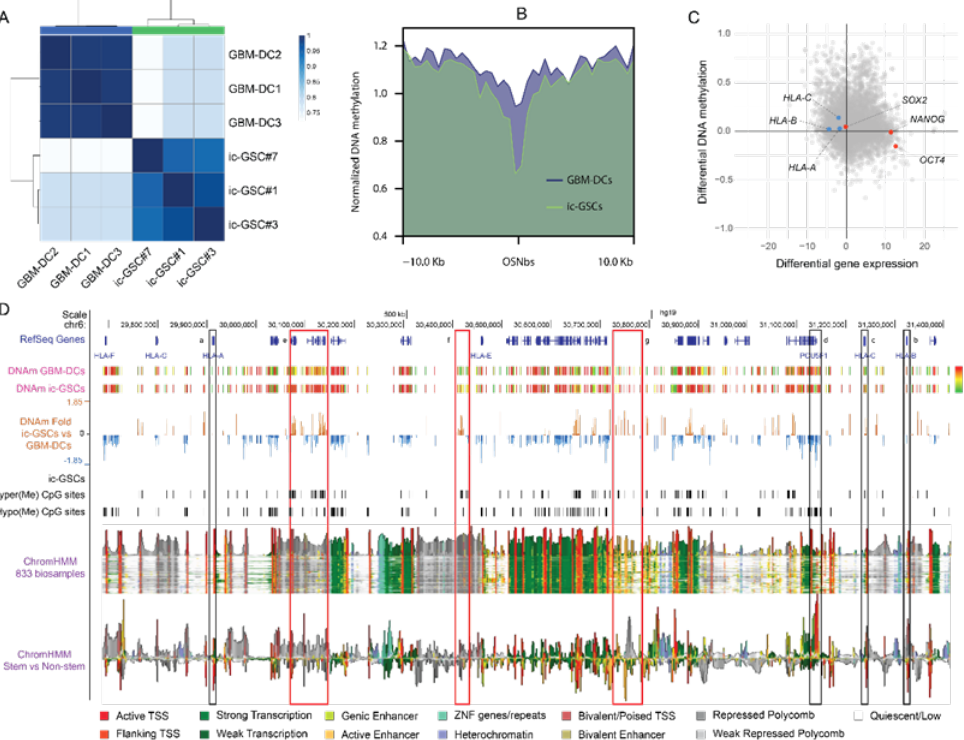
Figure 4. Epigenomic analysis of induced core glioma stem cells. ( A ) Correlation matrix for three GBM-DC replicates and three ic-GSC lines based on DNAm profile. ( B ) Profile plot representing the DNAm levels of GBM-DCs (blue) and ic-GSCs (green) around (±10 kb) consensus OCT4, SOX2, and NANOG binding sites (OSNbs). ( C ) Starburst plot including DMS ( y -axis) and DEG ( x -axis) in rep- resentative ic-GSC and c-GSC populations, highlighting stem-related factors OCT4, SOX2, and NANOG (red) and immune-associated antigen presentation genes HLA-A, -B, and -C (blue) ( D ) Representation of a 1.7 Mb genomic region (chr6: 29,685,442–31,426,907) encoding HLA-ABC genes and genes relevant for ic-GSC reprogramming. The view includes RefSeq Genes from NCBI, DNAm levels in GBM-DCs and ic-GSCs, DNAm fold change in ic-GSCs vs. GBM-DCs, hyper- and hypo- methylated CpG sites in ic-GSCs, chromatin state (ChromHMM) in 833 biosamples, and chromatin state in stem versus non-stem biospecimens. HLA-ABC and OCT4 (POU5F1) promoter regions are represented as black rectangles. Hypermethylated regions in ic-GSCs are represented as red rectan- gles.